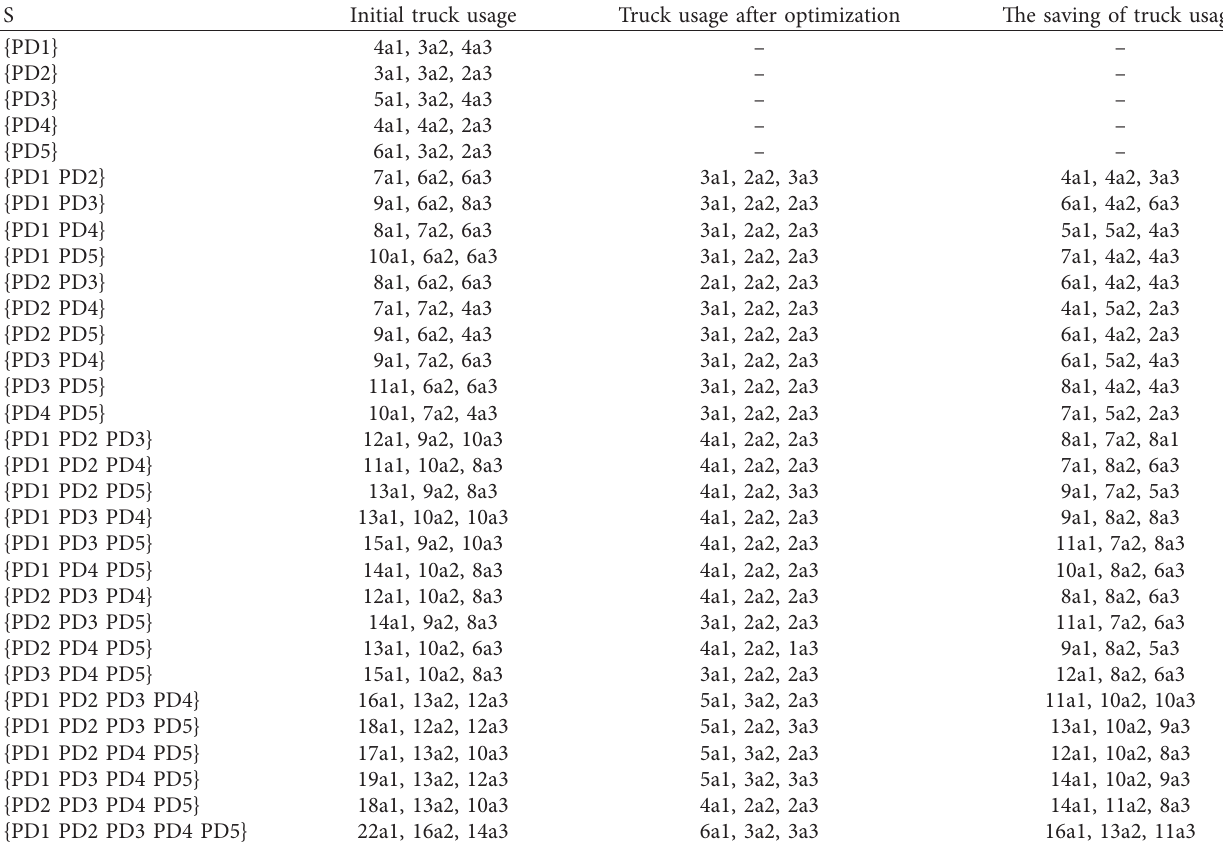
Table 9: Comparison of the truck usage between initial and optimized networks.